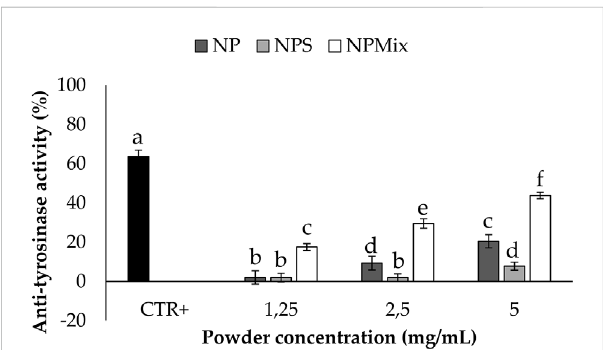
FIGURE 7 Results oftheanti-tyrosinase activityofthesamples.The positive control is arbutin tested at a 1.25 mg/mL concentration in deionized water. Data are reported as mean value ± LSD, Multifactor ANOVA, n = 3. Letters (a,b,c,d,e and f) are used to compare the means of different groups. If the letters are different, there is a statistically signi fi cant difference between the means ( p < 0.001); if the letters are the same, there is no statistically signi fi cant difference between the means ( p > 0.05).